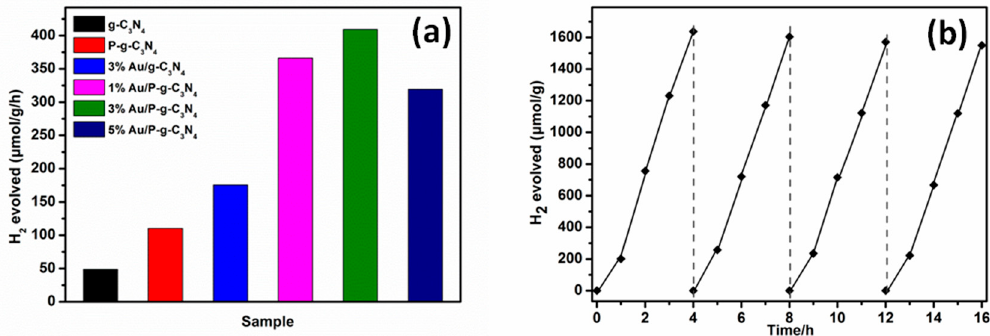
Figure 5. Photocatalytic activities for ( a ) H 2 generation rates for prepared photocatalysts under visible light illumination. ( b ) Circling runs of 3% Au/P-g-C 3 N 4 composite for H 2 generation rates under visible light irradiation.